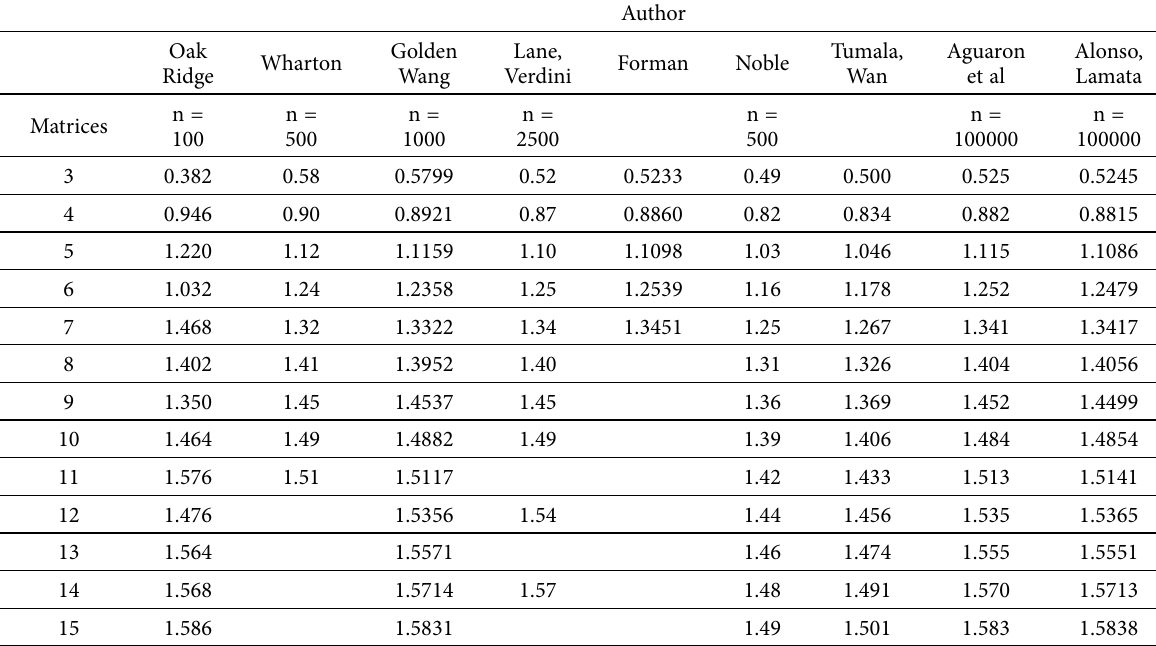
Table 2. RI (n) values from various authors (Alonso, Lamata 2006)